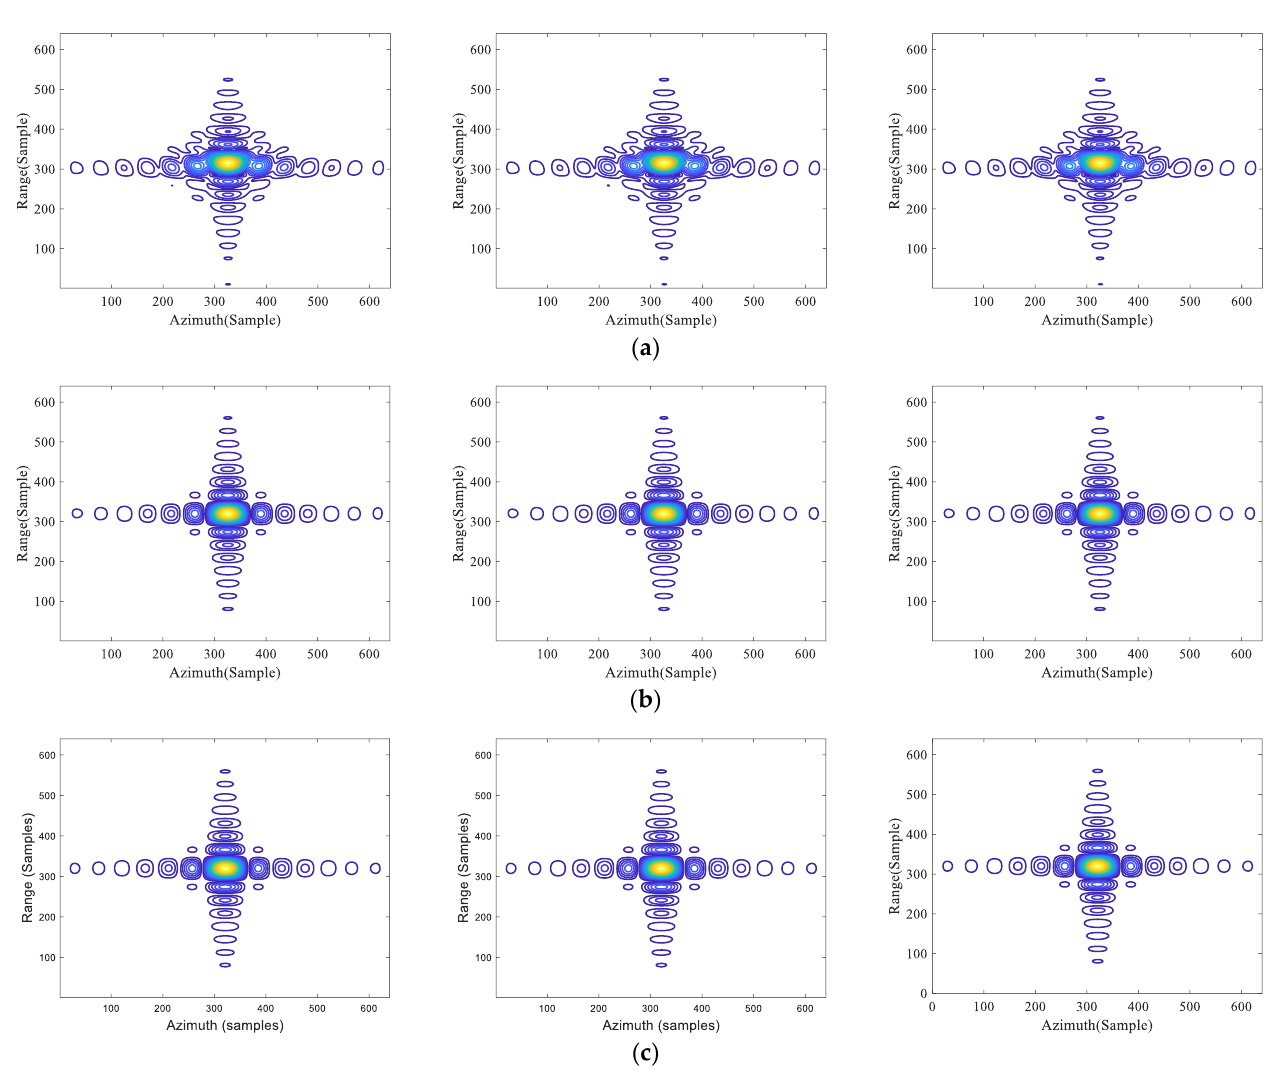
Figure 11. Contour map of spectral fusion results for PT1. ( a ) Single sub-aperture fusion; ( b ) Two sub-aperture fusion; ( c ) Three sub-aperture fusion.